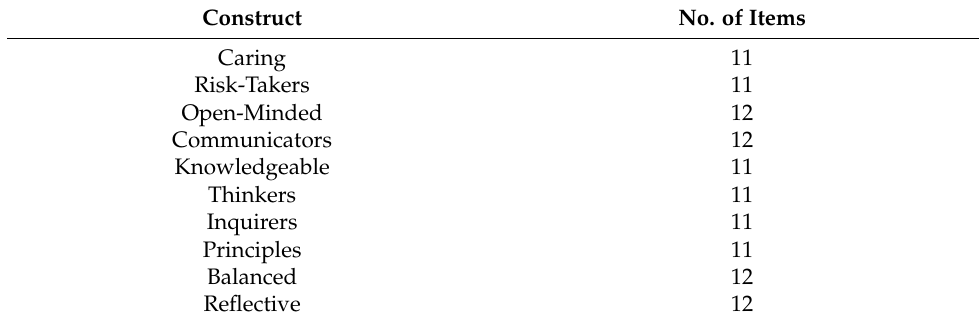
Table 1. Number of items by